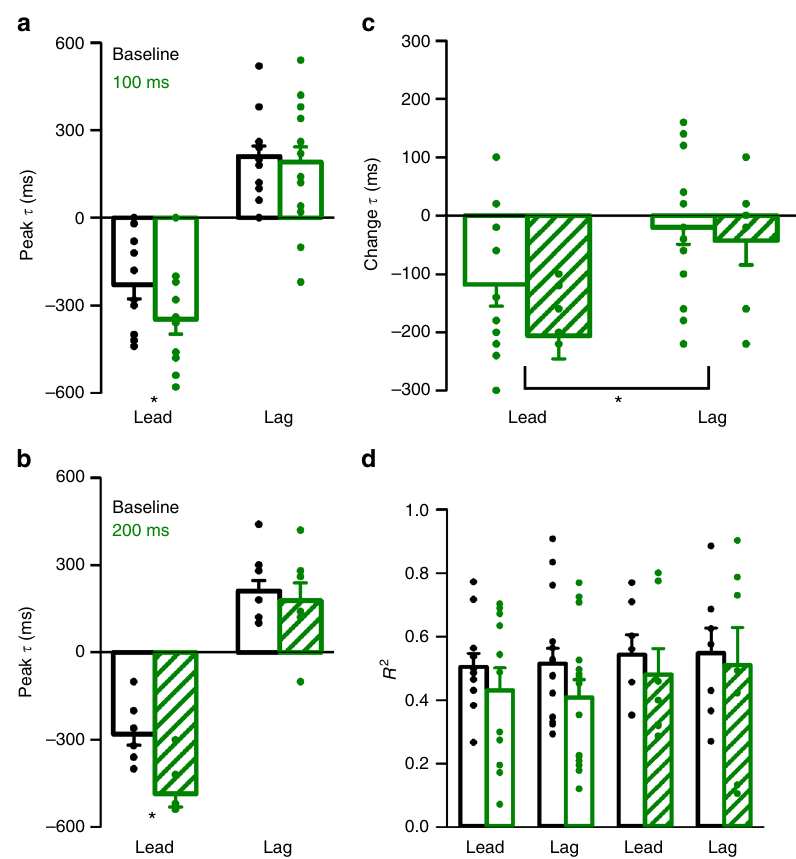
Fig. 4 Delay condition population results for the position error encoding. a , b Average peak timing of encoding across the population illustrates the signi fi cant shift in timing of lead encoding for both 100 ms ( a , t (10) = 3.18, p = 0.01, paired t -test) and 200 ms ( b , t (6) = 5.15, p = 0.002, paired t -test) delays. c The time of lag encoding was not signi fi cantly affected for either delay ( t (10) = 0.68, p = 0.51 for 100 ms, paired t -test and t (6) = 1.03, p = 0.34 for 200 ms, paired t -test). Average change in the timing of lead and lag encoding in the 100 ms (solid green) and 200 ms (checkered green) conditions, illustrating a signi fi cant shift in the timing of lead SS encoding ( F (1,39) = 11.732, p = 0.002, ANOVA). d Average R 2 of lead and lag SS encoding of position error, indicating no signi fi cant change in encoding strength for either delay condition ( F (1,79) = 1.31, p = 0.27, ANOVA). Error bars in this and all fi gures indicate visual feedback by not displaying the cursor inside the target (Fig. 5). Reducing the visual feedback tests if the lagged SS modulation with position error is driven by the visual feedback. Compared to the baseline condition (Fig. 5a), the modulation should decrease whenever the cursor is inside the target (Fig. 5c). Conversely, if the lead SS encoding is predicting the position errors based on the motor commands, it should be unaffected. In the hidden condition, the R 2 temporal pro fi le for the lagging SS modulation with position error is expected to decrease and lead modulation should not change (Fig. 5b vs. 5d).